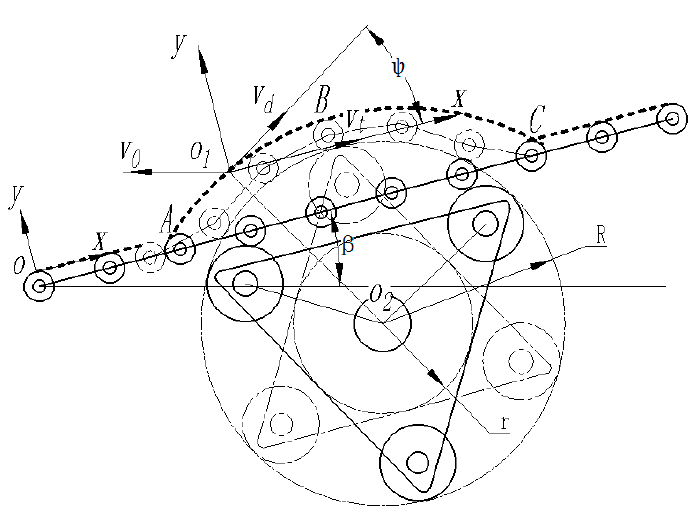
Figure 8. Jitter analysis diagram. X is the direction of movement of the chain; Y is perpendicular to the direction of chain movement; A is the starting point of the normal motion of the chain; B is the highest point of the normal motion of the chain; O is the initial coordinate origin; O 1 is the coordinate origin during the chain jitter; O 2 is the center of rotation of the jitter roller; r is the radius of the inner tangent circle of the jitter roller’s rotation; R is the radius of the outer tangent circle of the jitter roller’s rotation; β is the angle between the chain and the horizontal direction; V 0 is the forward speed of the machine (m/s); V d is the speed of the jitter roller acting on the film-soil mixture (m/s); V t is the velocity of the chain link acting on the film-soil mixture (m/s).